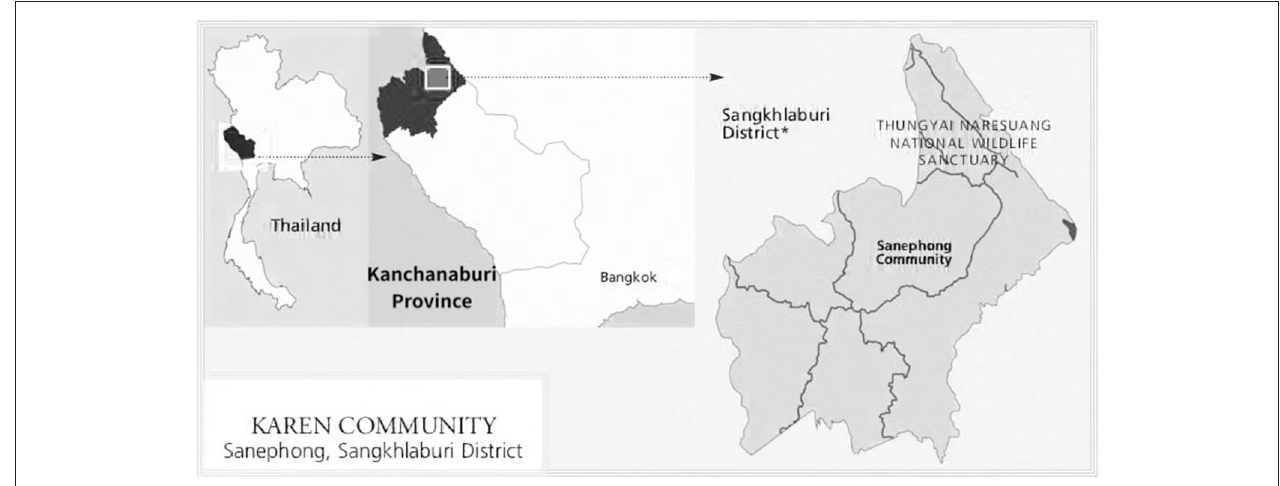
FIGURE 2 | Karen Community in Sanepong, Kanchanburi Province,